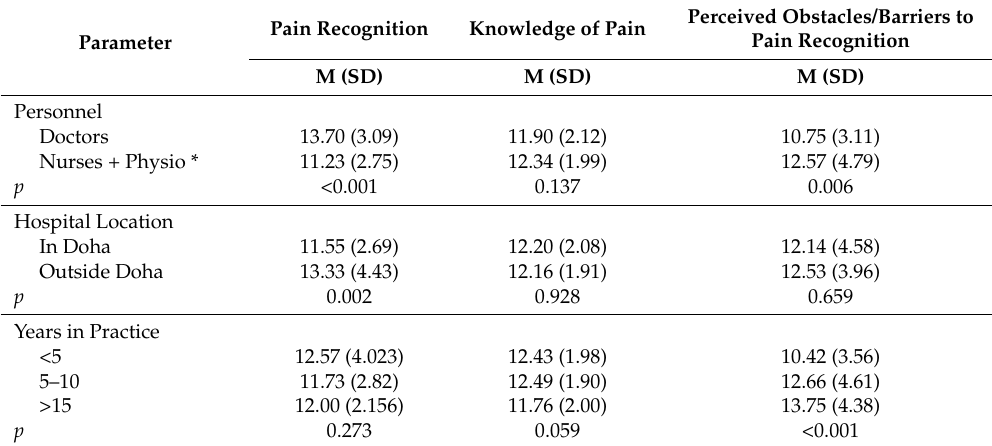
Table 5. Mean sum of scores for each questionnaire section by selected